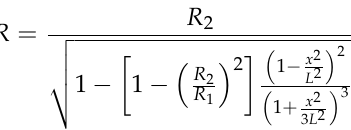
Figure 2 illustrates the Vitoshinsky curve diagram.